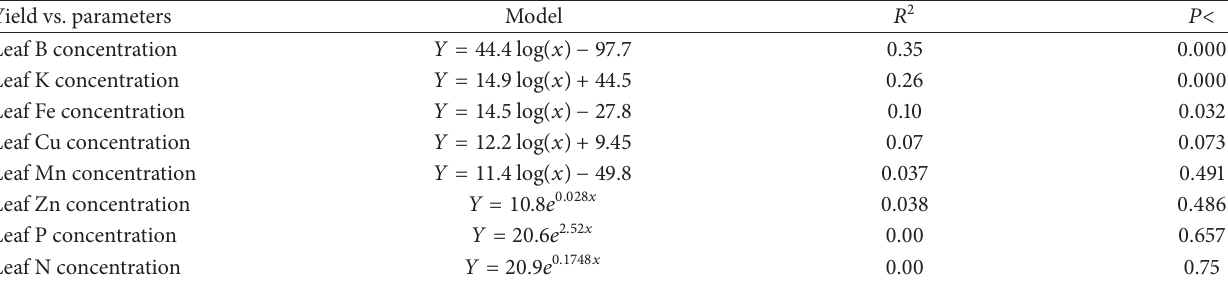
Table 7: Correlations between olive fruit yield (𝑌) and leaf nutrients (𝑥) sorted in descending order of 𝑅 2 . Coefficients of determination (𝑅 2 ) and statistical significance (𝑃) are also